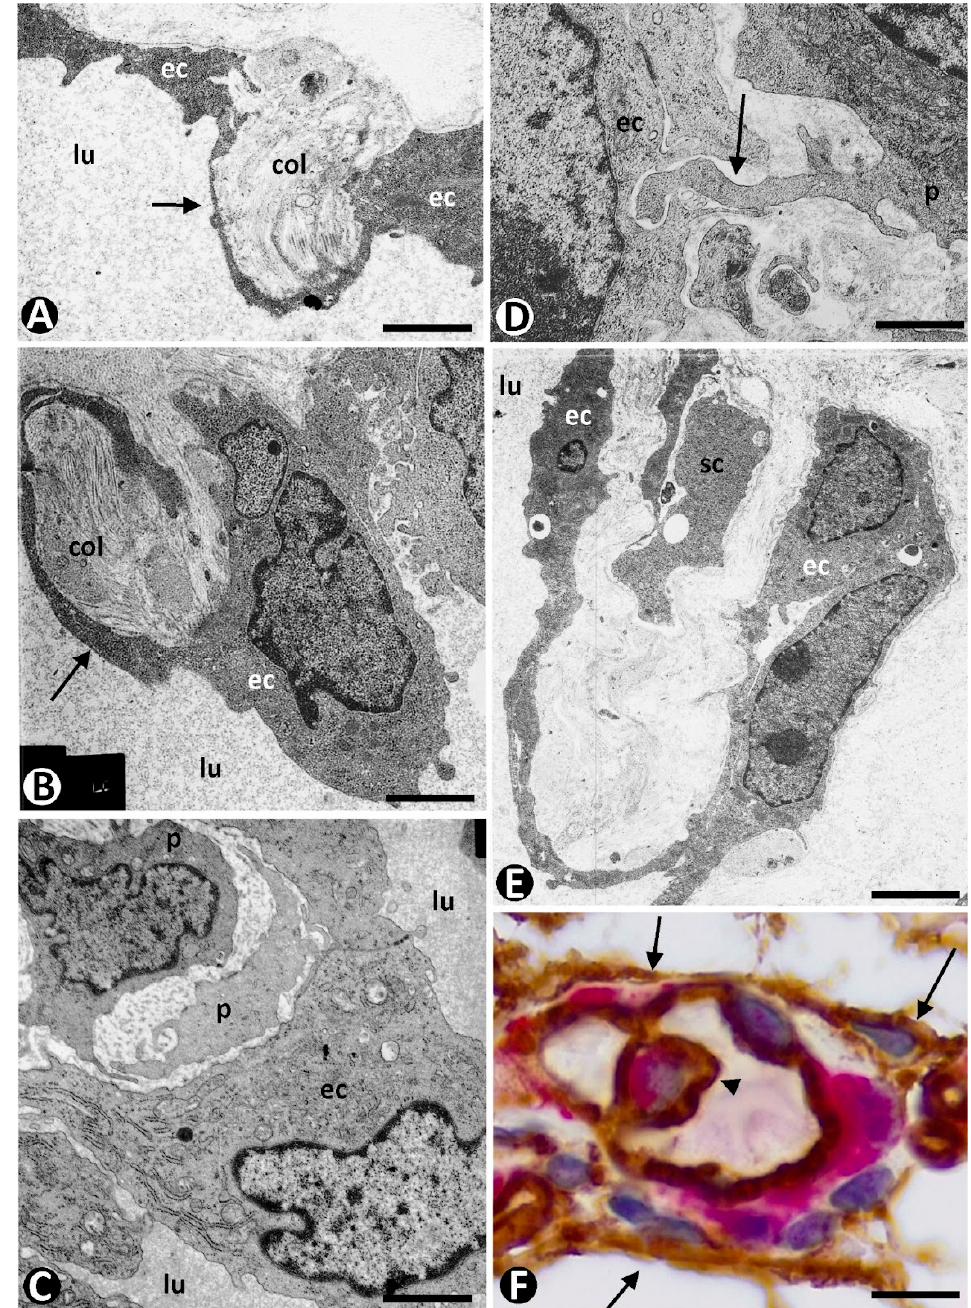
Figure 11. Pericytes and stromal cells in intussusceptive angiogenesis. ( A – C ): Intravascular pillars in successive stages of formation. Note in ( A , B ), collagen (col) incorporating in the core of pillars (arrows) surrounded by a cover formed by extending endothelial cells. In ( C ), pericytes (p) are present in the core of a pillar surrounded by prominent endothelial cells (ec). ( D ): A peg-and- socket junction (arrow) observed between a pericyte (p) and an endothelial cell (ec). ( E ): A pillar surrounded by endothelial cells (ec) and in the core of collagen and some stromal cell (sc) processes. ( F ): Immunohistochemistry demonstration of CD34+/SCs (brown) (arrows) around a vessel wall with a pillar (arrowhead) made up of a cover formed by ECs and a core with pericytes (red). lu: vessel lumen. ( A – E ): Ultrathin sections, Uranyl acetate, and lead citrate. ( F ): Double immunohistochemistry for CD34 (brown) and α SMA (red). Bar: ( A , B ): 2.5 µ m; ( C ): 1 µ m; ( D ): 2 µ m; ( E ): 2.5 µ m; ( F ): 15 µ